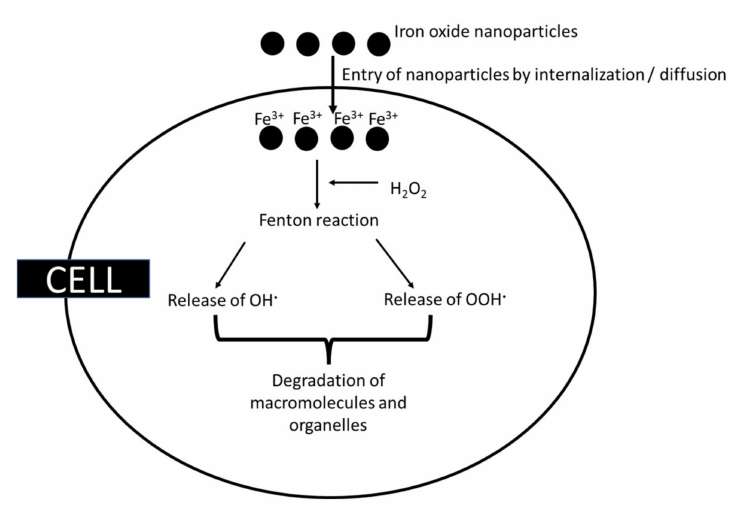
Figure 3. Oxidative damage caused by iron oxide